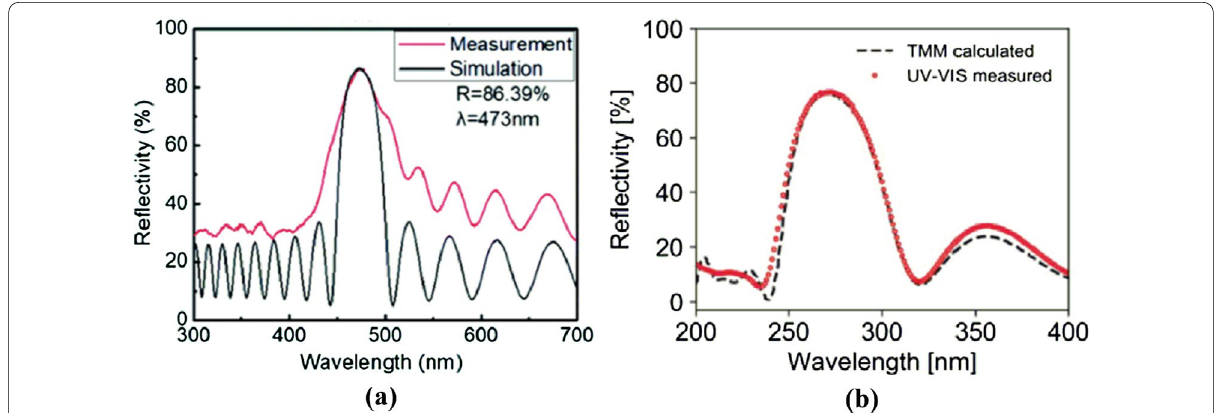
Fig. 13 Measured and calculated reflectance spectra of the designed DBR deposited with a MOCVD, b ALD [84,